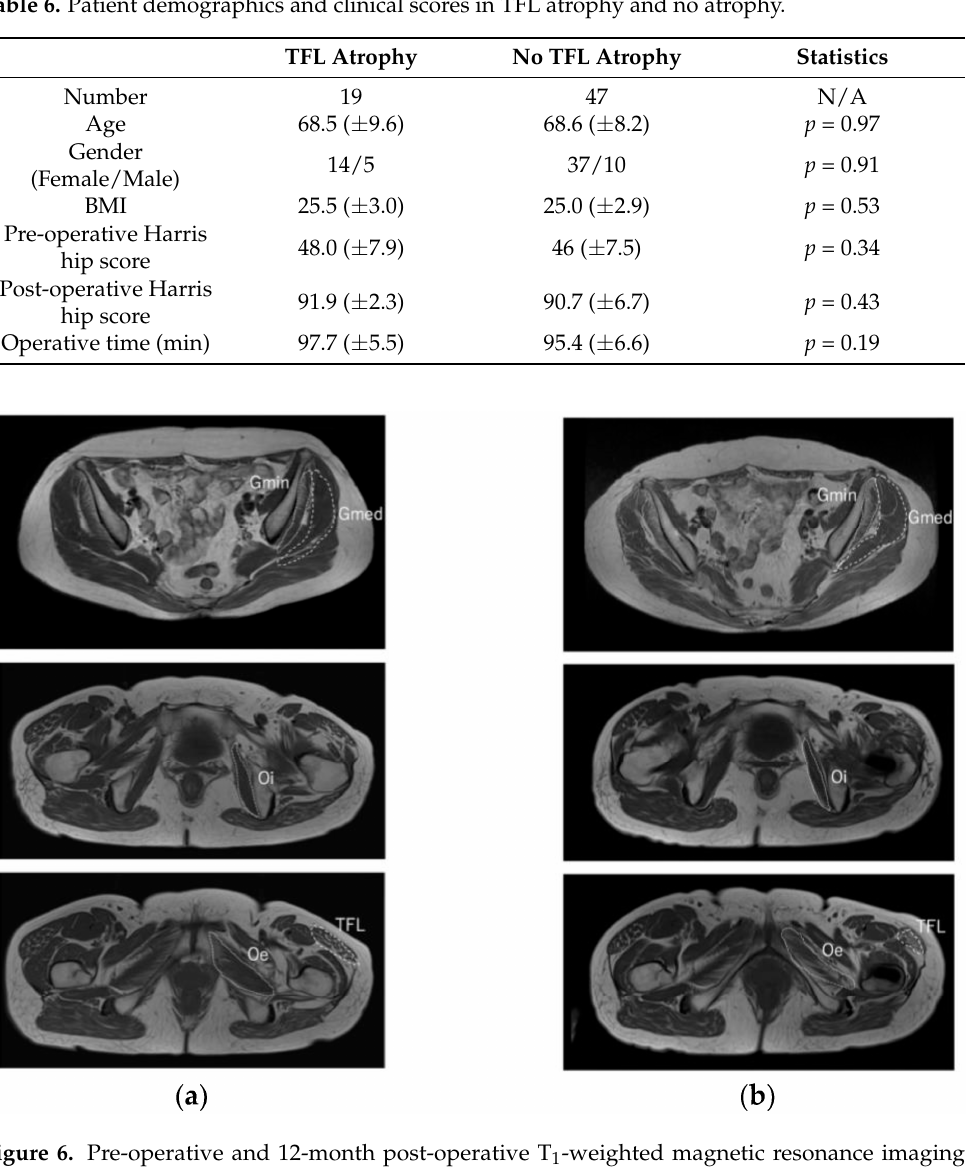
Table 5. Post-operative fatty atrophy change of each muscle.